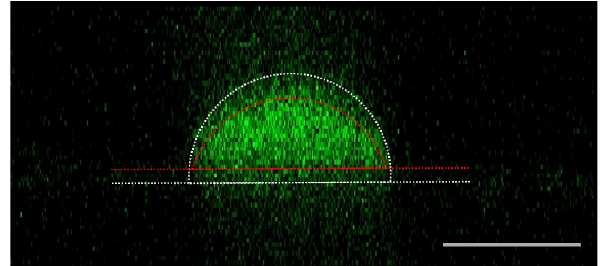
Figure 5. Side-view image of isoprene-derived SOM recorded with a confocal fluorescence microscope (Leica SP5 II, 10 × ob- jective). The image was generated with λ excitation = 458nm and λ emission = 465–700nm at the temperature of 293 ± 1K. The two sets of dashed lines trace the boundaries of the particle from which the contact angle is measured. The white dashed lines encompass the maximum possible boundary with a contact angle of 90 ◦ while the red dashed lines surround the brightest hence the minimum boundary of the particle with a contact angle of 60 ◦ . The size of the scale bar is 20µm.